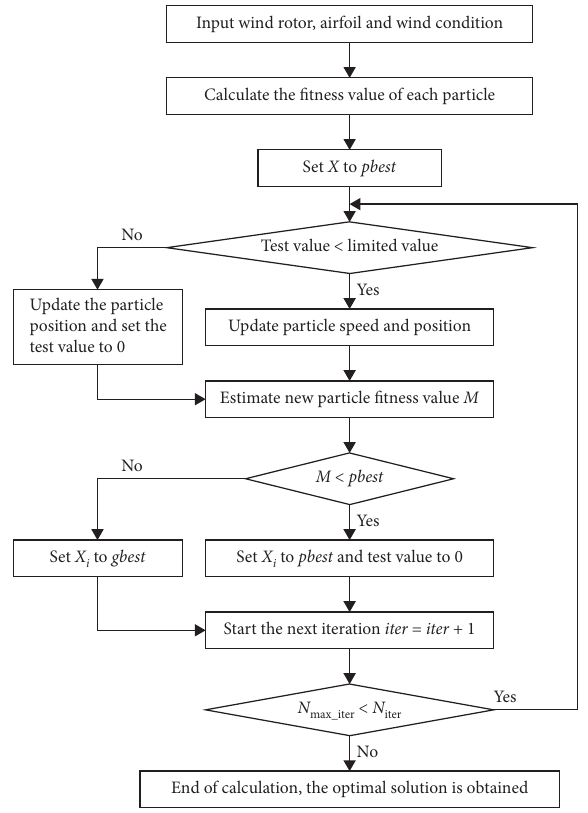
Figure 1: Flowchart of optimization Table 1: Design parameters.